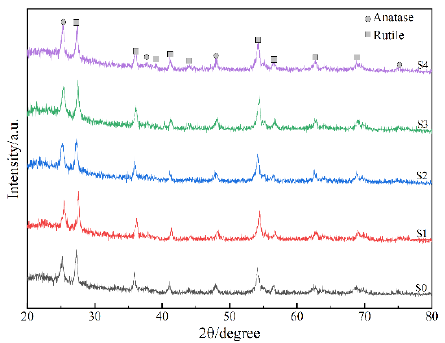
Figure 6. XRD pattern of MAO coating.